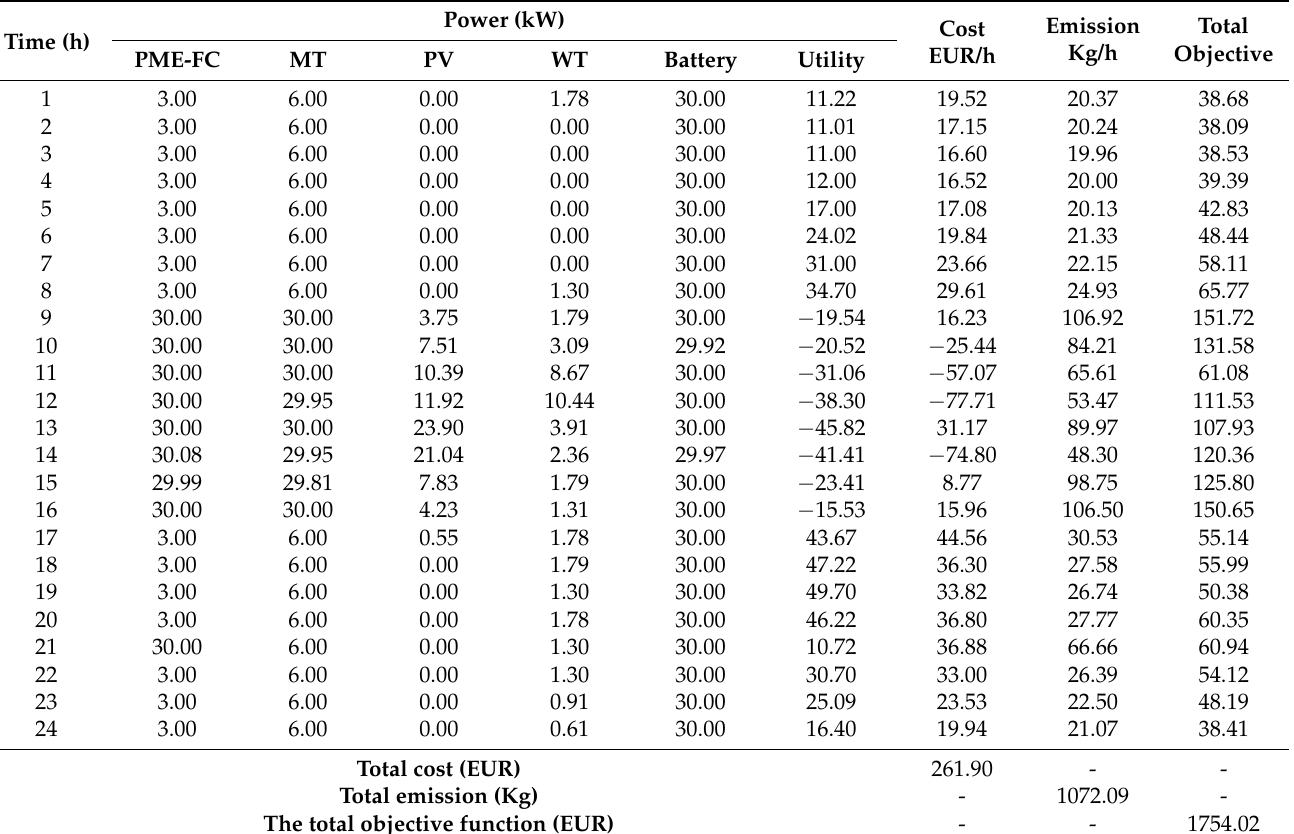
Table 6. The best results obtained using the EO for the EM problem for Scenario 3 (Case